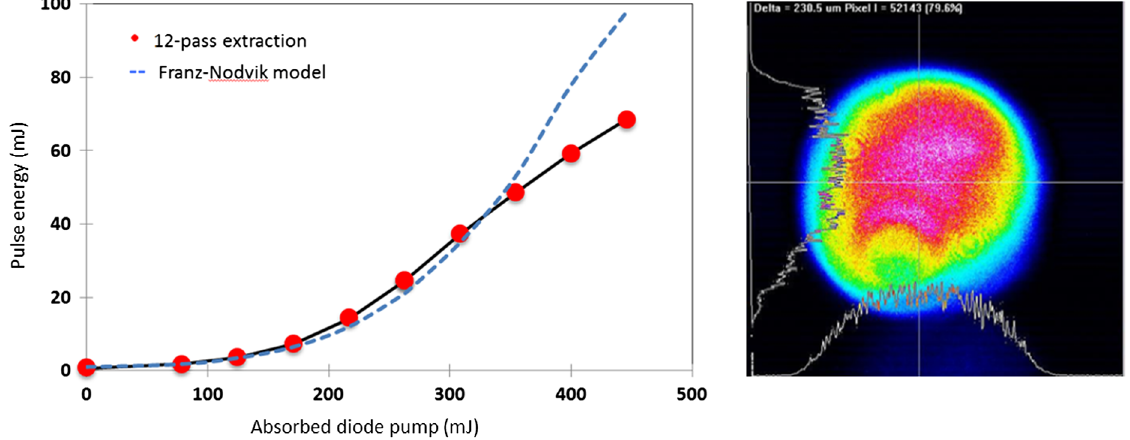
FIG. 16. (left) Achieved pulse energy at 200 Hz using a high-energy high-power cryogenic composite-thin-disk Yb ∶ YAG amplifier and (right) the near field beam pattern at 60 mJ pulse energy.